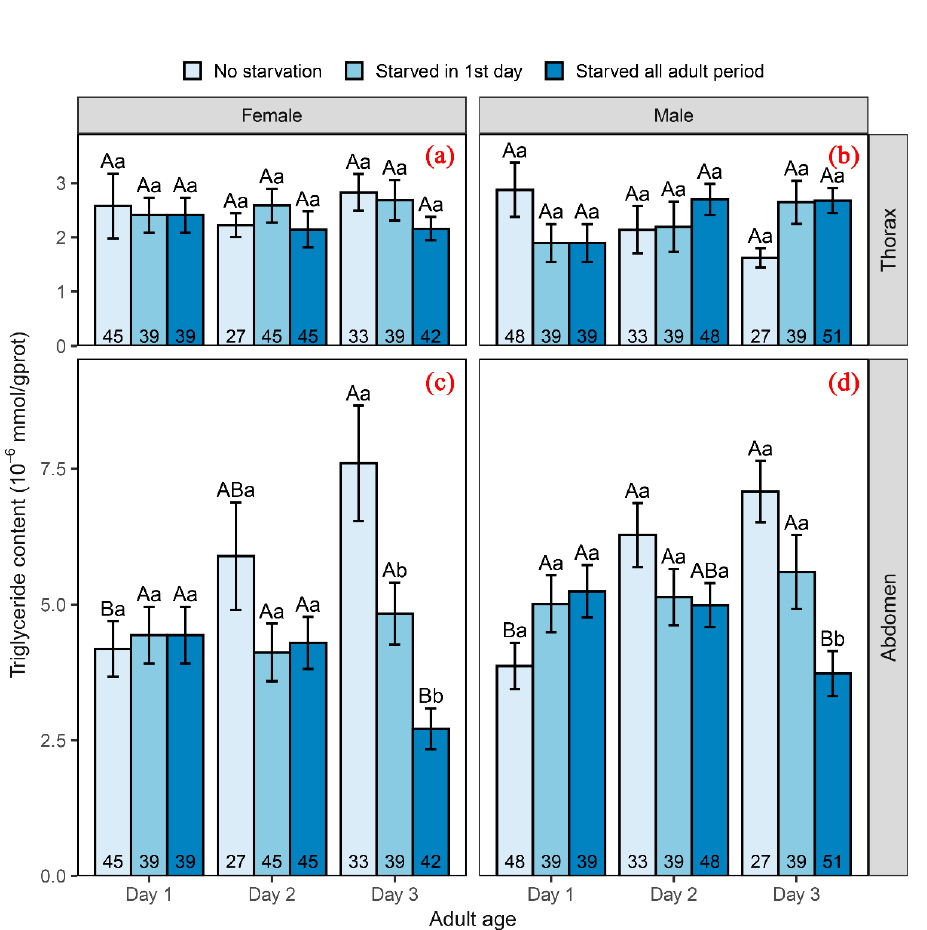
Figure 3. Triglyceride content of thorax in female ( a ) and male moths ( b ) and triglyceride content of abdomen in female ( c ) and male moths ( d ) . Different uppercase letters indicate significant differences between different starvation treatments, and different lowercase letters indicate significant differences between different adult ages. The numbers in the bars indicate sample sizes.